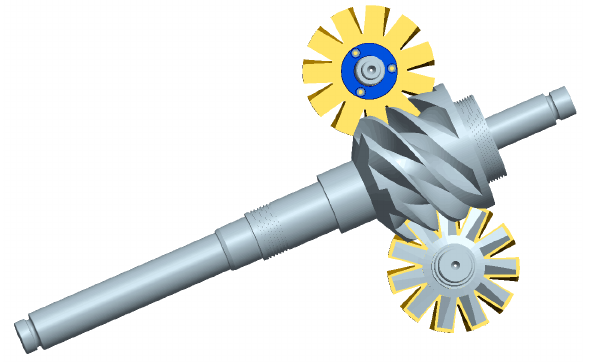
Figure 2. Three-dimensional structure of the single-screw expander.